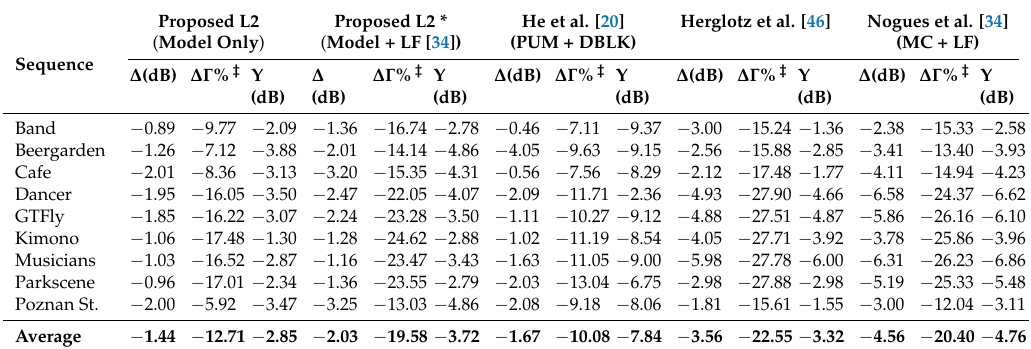
Table 3. Decoding-complexity-reduction performance.